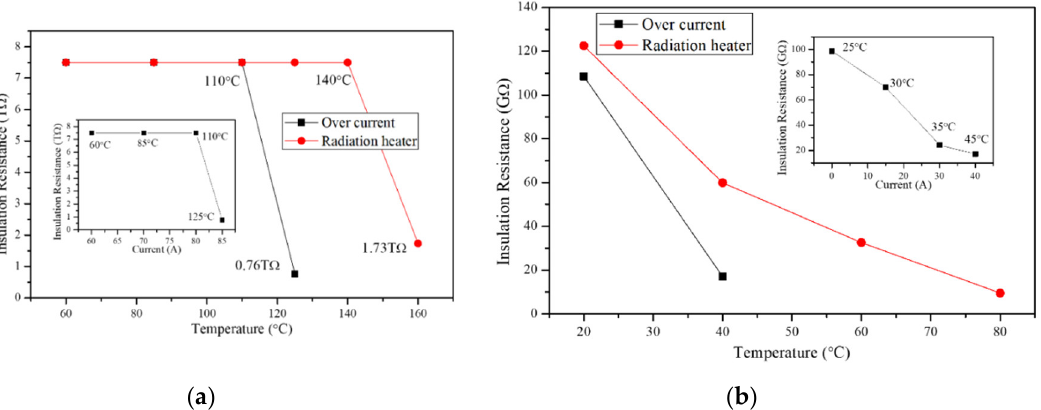
Figure 8. Insulation resistance characteristics of the cables by the over-current and convection heater.